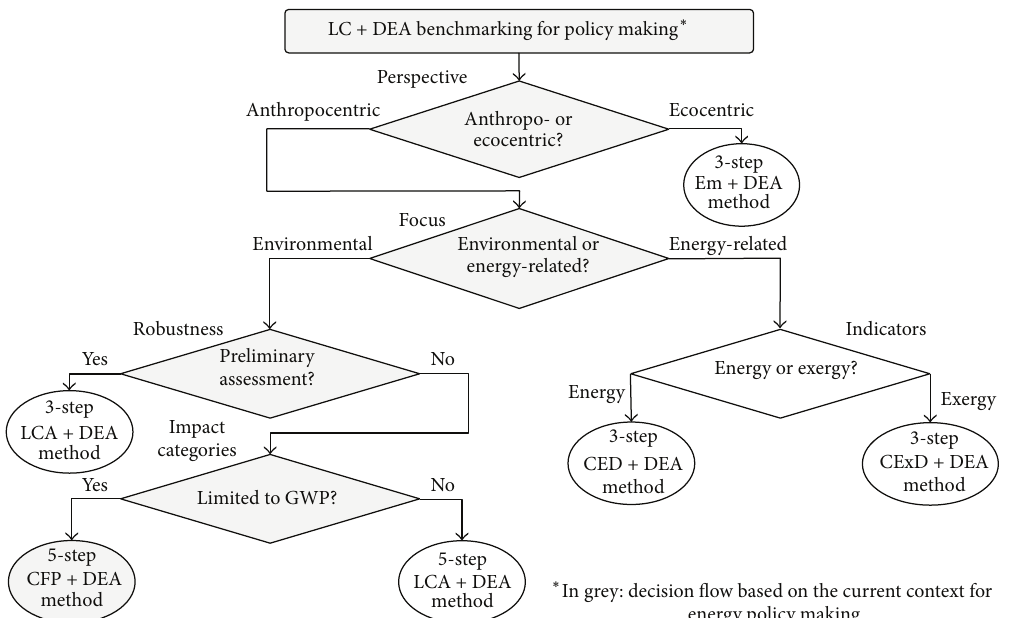
Figure3:DecisionflowcharttoselectthemostappropriateLC+DEAmethodforpolicymakingaccordingtocurrentmethodologicaloptions (including the CFP + DEA